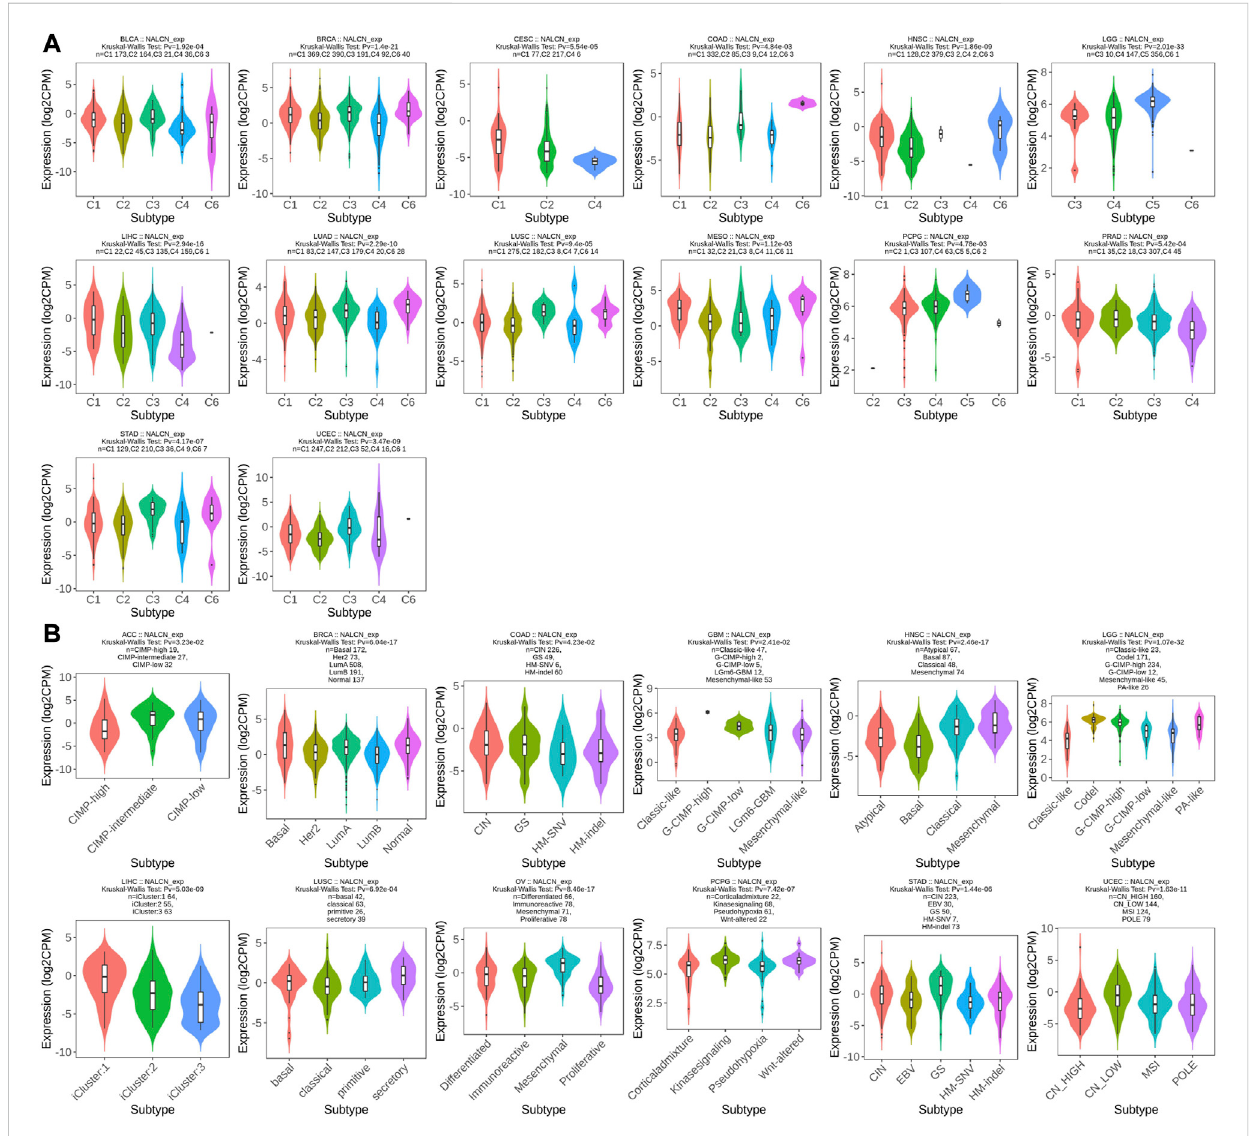
FIGURE 5 Correlation of NALCN expression and clinicopathological parameters (immune subtype, molecular subtype) across different cancer types. (A) Correlation of NALCN with immune subtypes (C1: wound healing, C2: IFN-gamma dominant, C3: in fl ammatory, C4: lymphocyte depleted, C5: immunologically quiet, C6: TGF-b dominant) of BLCA, BRCA, CESC, COAD, HNSC, LGG, LIHC, LUAD, LUSC, MESO, PCPG, PRAD, STAD, UCEC, based on the TISIDB database. (B) Correlation of NALCN with molecular subtypes of ACC, BRCA, COAD, GBM, HNSC, LGG, LIHC, LUSC, OV, PCPG, STAD, UCEC, based on the TISIDB